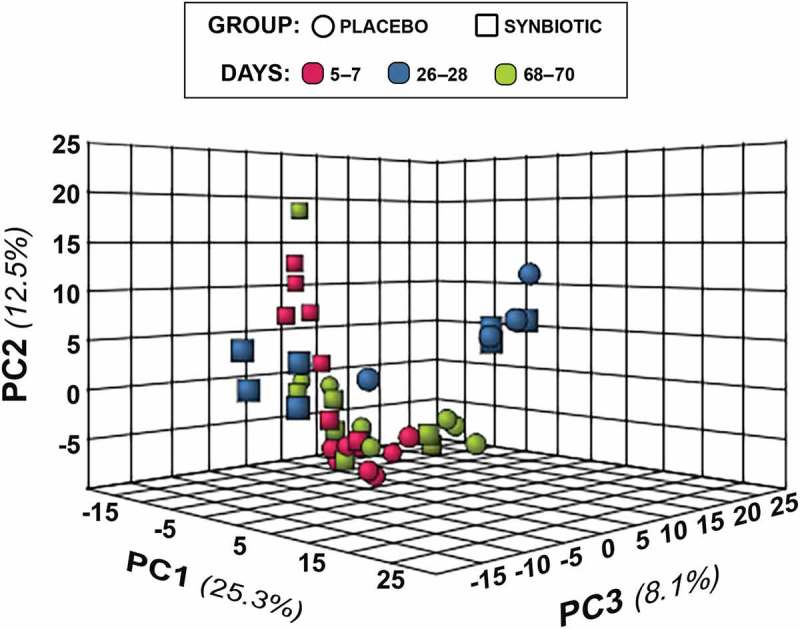
Principal component analysis (PCA) of metabolic pathway analyses from feline fecal samples.Samples were collected at baseline (days 5–7), at the conclusion of antibiotic administration (days 26–28), and after a 6-week washout (days 68–70) from 16 healthy cats, 8 per group,+ that received 75 mg clindamycin followed 1 h later by either two capsules of a placebo or synbiotic PO once daily for 21 days. +Feces not available from four cats at time point 26–28 because of early termination of treatment due to severe gastrointestinal signs.